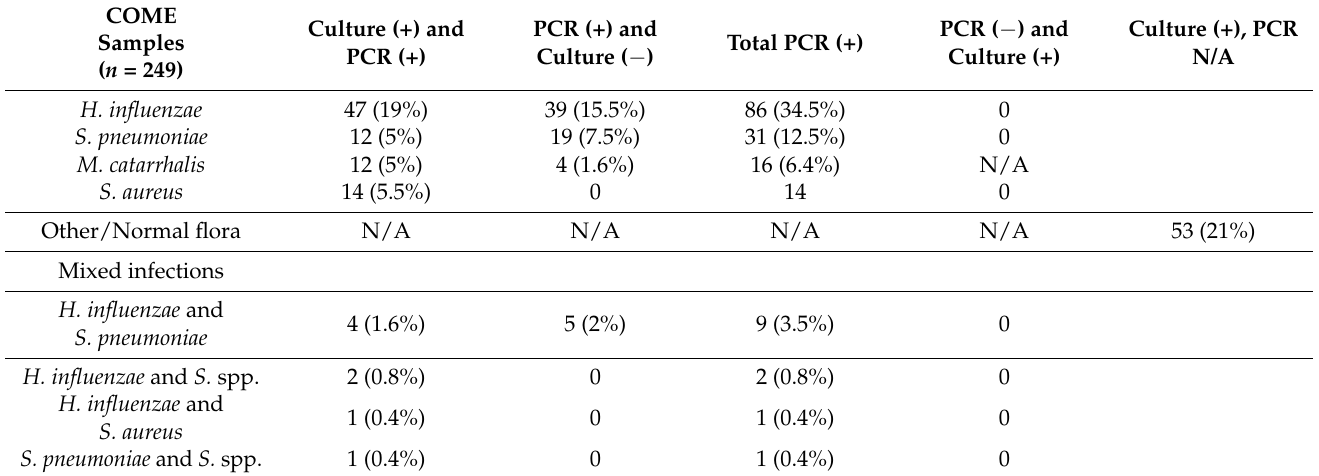
Table 1. Pathogen identification in COME samples by culture and PCR.